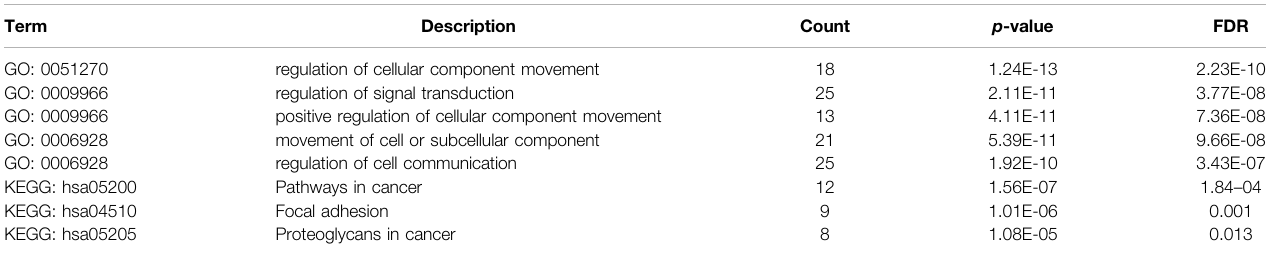
TABLE 1 | Functional enrichment analysis of DEGs in